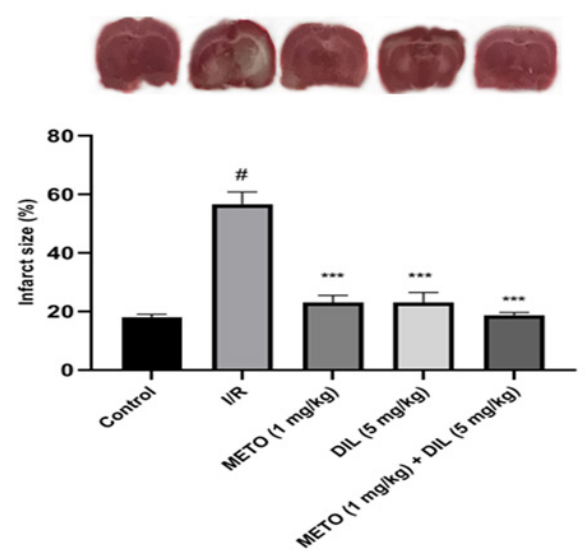
FIGURE 1 - (A) Representative images of TTC stained sections of the brain after cerebral ischemia/reperfusion; (B) The effects of pre-treatment with metoprolol (1 mg/kg/ day) and diltiazem (5 mg/kg/day) alone and in combination on infarct size in cerebral ischemia-reperfusion; data are expressed as mean±S.E.M. N=6. # P<0.001 vs. control group. *** P<0.001 vs. I/R group using one-way ANOVA with Tukey post-test. I/R: Ischemia/reperfusion; METO: Metoprolol; DIL: